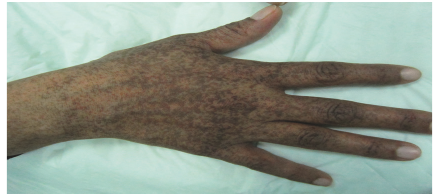
Figure 3: Reticulate acropigmentation of Kitamura: pronounced reticulated and confluent hyperpigmentation is noted over the dorsum of the